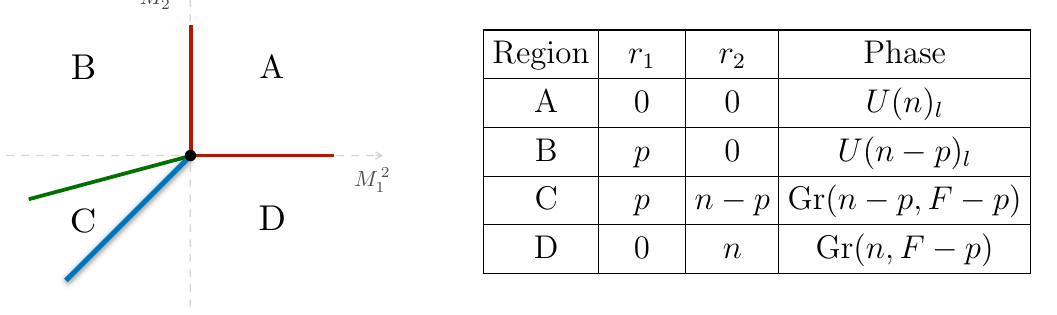
n < F p F . The region of ≤ − ≤ R